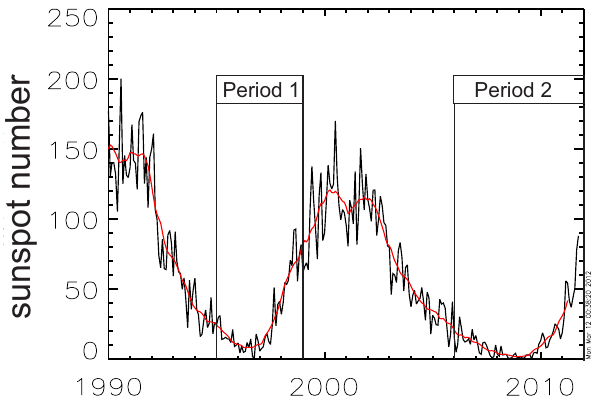
Fig. 1. Monthly (black) and monthly smoothed (red) sunspot num- bers from Solar Influences Data Center from January 1990 through December 2011. Our study periods are indicated in the